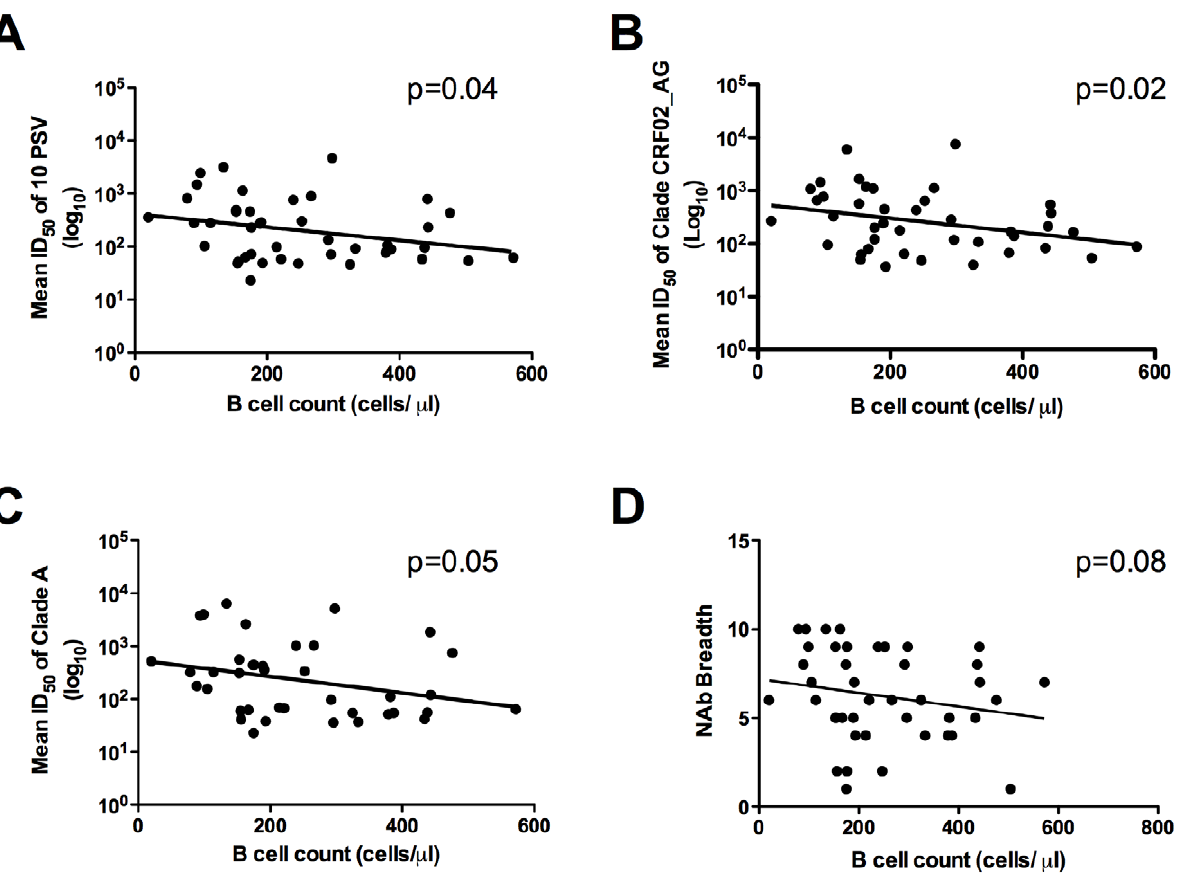
Figure 3. B lymphocyte absolute counts in HIV-1 subtype A infected Ugandans correlate inversely with neutralizing antibody titers against different HIV-1 subtypes. Neutralizing antibody responses in sera of 50 HIV-1 subtype A infected patients were determined against a panel of 10 pseudoviruses in the TZM-bl Assay. The mean ID 50 using each serum sample against all 10 pseudoviruses or against all pseudoviruses within a subtype was calculated. B lymphocyte numbers showed a significant inverse correlation with neutralizing antibody titers against the mean ID 50 of all 10 pseudoviruses (A) and with the mean ID 50 for subtype CRF02_AG (B); the same trend was observed for subtype A viruses (C). B lymphocyte numbers also showed a trend towards inverse correlation with breadth (number of panel viruses neutralized) (D).